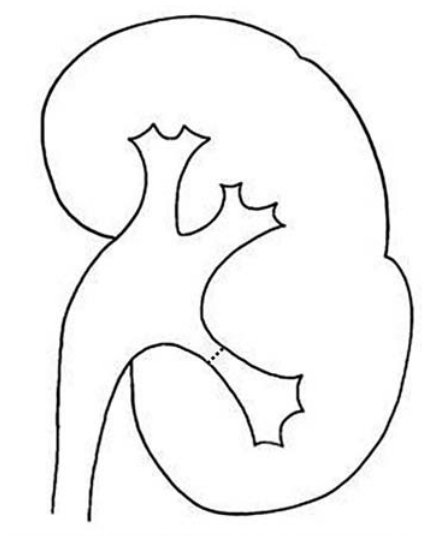
Figure 3 – Infundibular height (mm), measured as the distance between the horizontal line passing through the lowermost part of the calyx containing the calculus and the highest point of the lower lip of the renal pelvis.